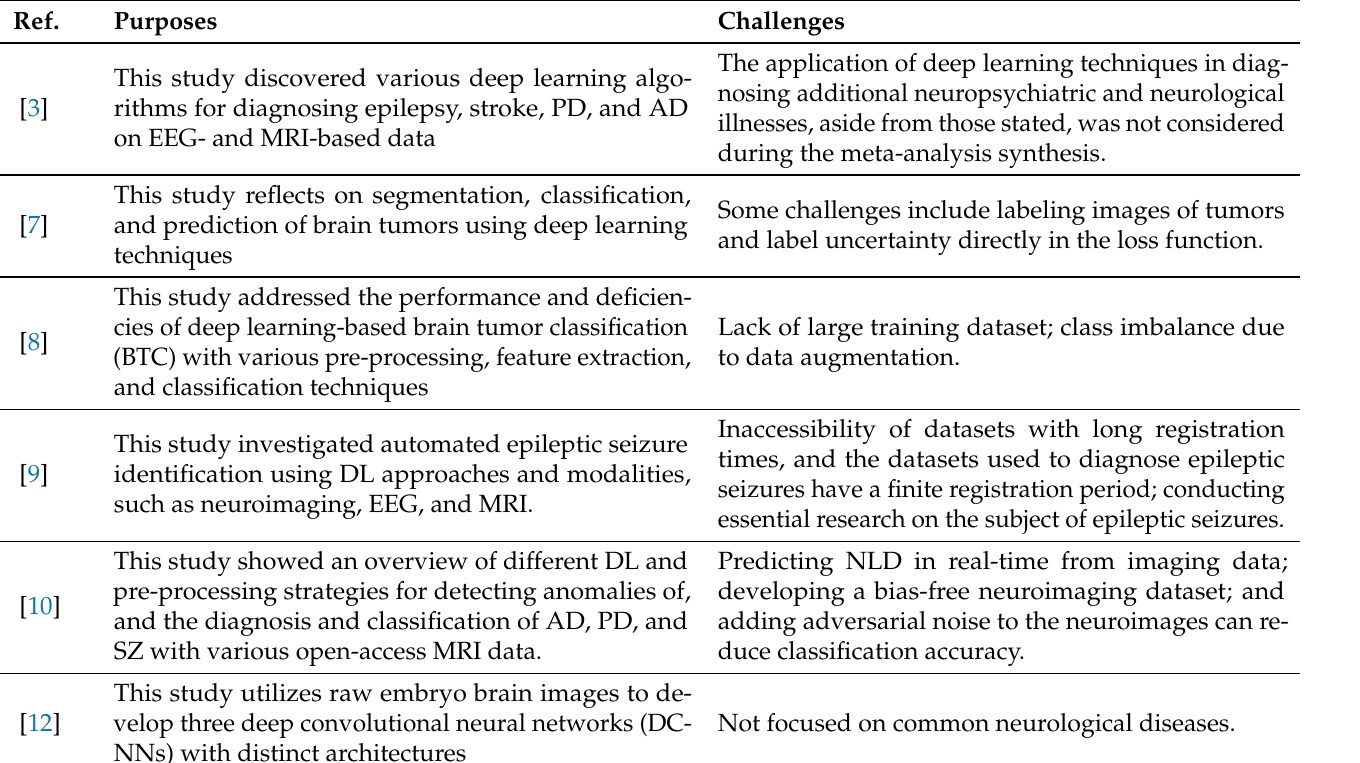
Table 1. Neurological diseases-related recent surveys